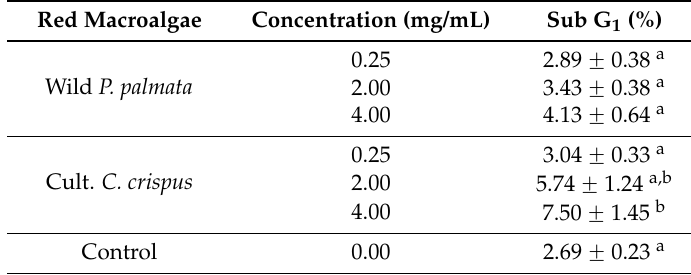
Table 4. Effect of wild-harvested and cultivated red macroalgal extracts on HeLa cell cycle 1